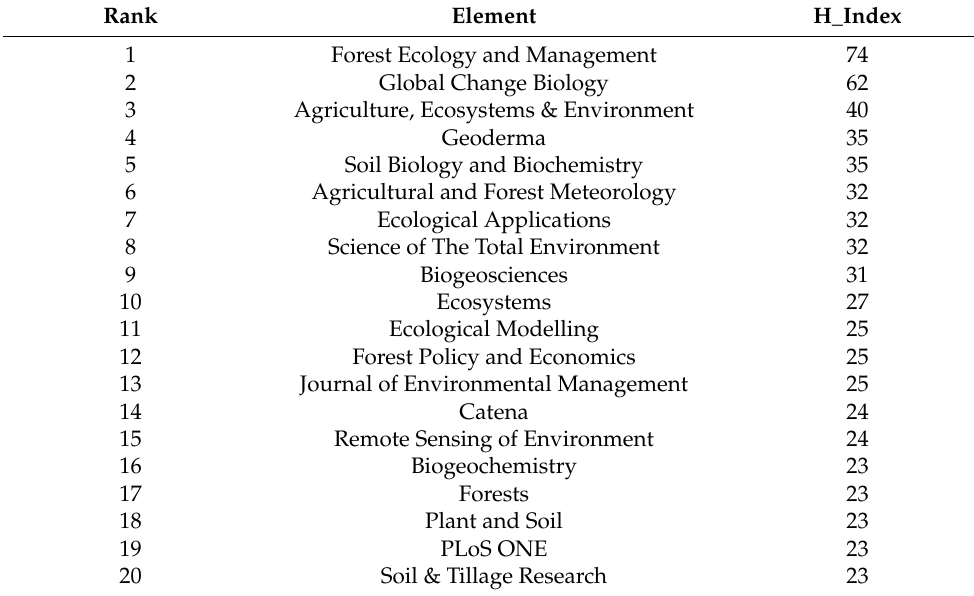
Figure 5. Top 20 most published journals in the research field by 2002–2022. Table 5. The 20 highest h_index of journals in the research field from